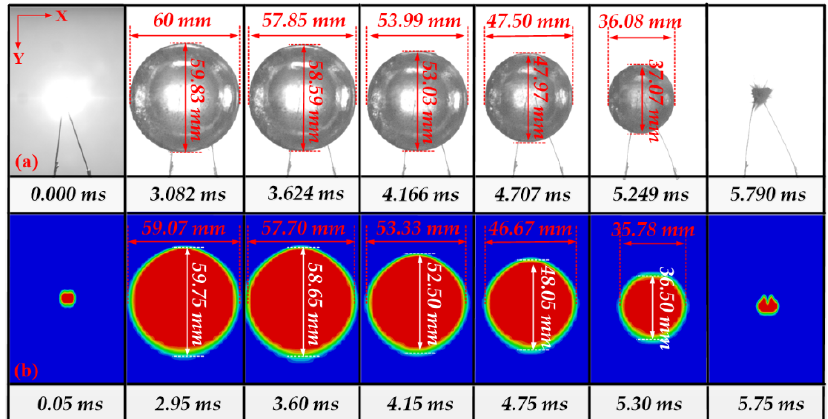
Figure 8. Pulsation chart of the first cycle of the bubble under free-field conditions: ( a ) Electric spark bubbles generated by 400 V high-voltage electric discharge; ( b ) high-pressure cavitation bubbles simulated by ABAQUS/Explicit.